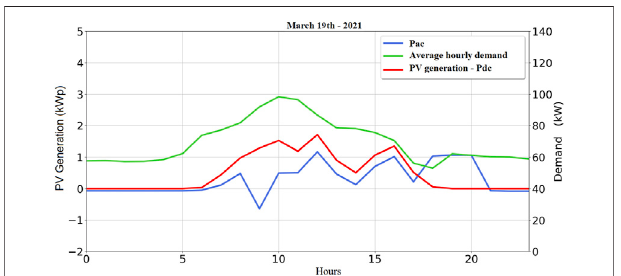
FIGURE 7 | The PV generation pro fi le with days of minimum hourly irradiation for the academic weekday – 03/19/2021 versus average hourly demand of March/2019. Data Sources: the authors.